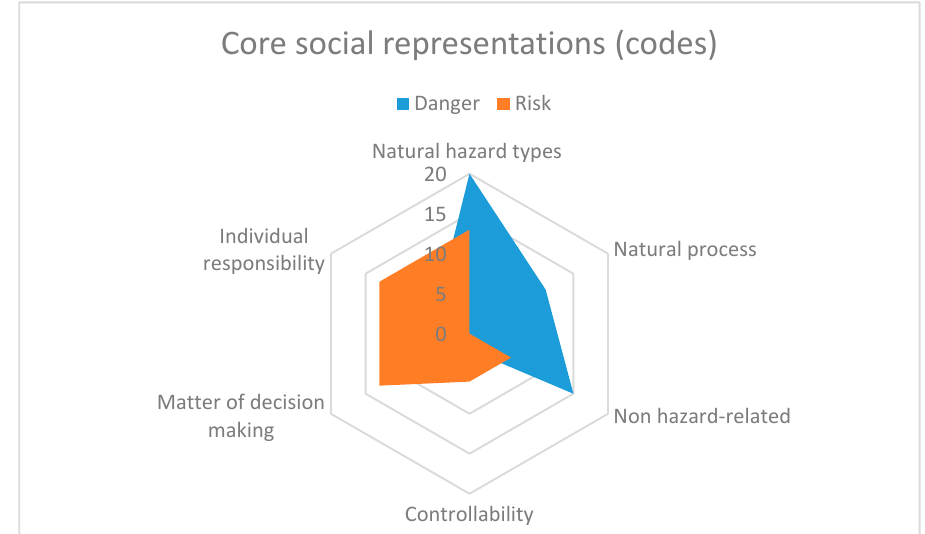
Figure 8. Core social representations of risk and danger ( ≥ 8 namings).